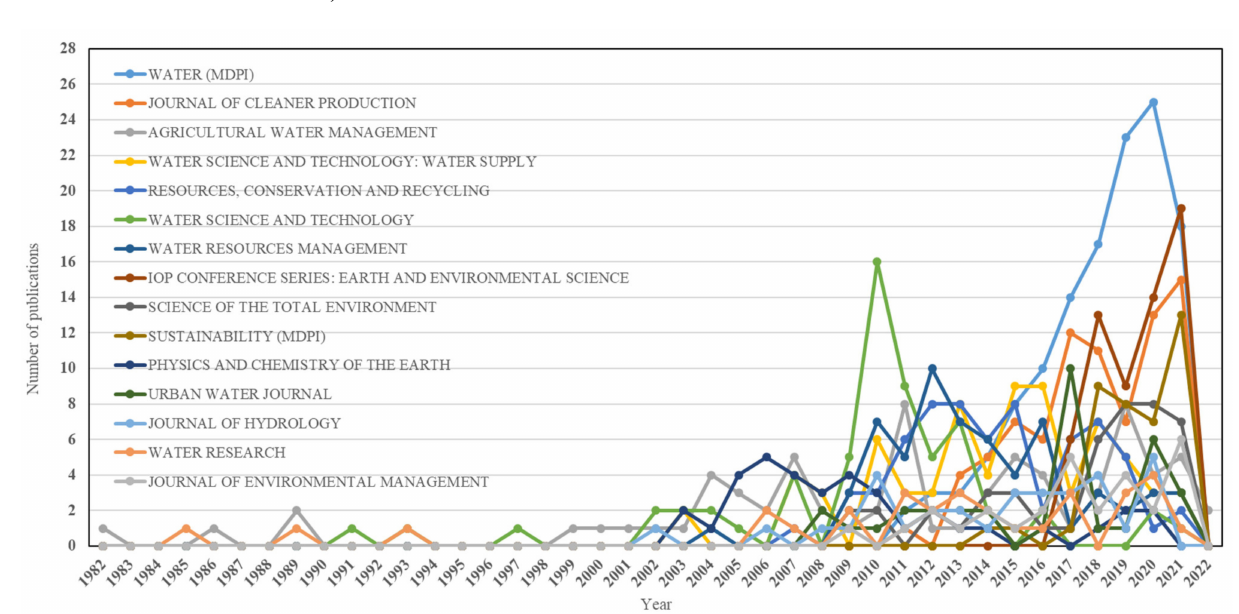
Figure 3. Timeline of publications in the top 15 journals,